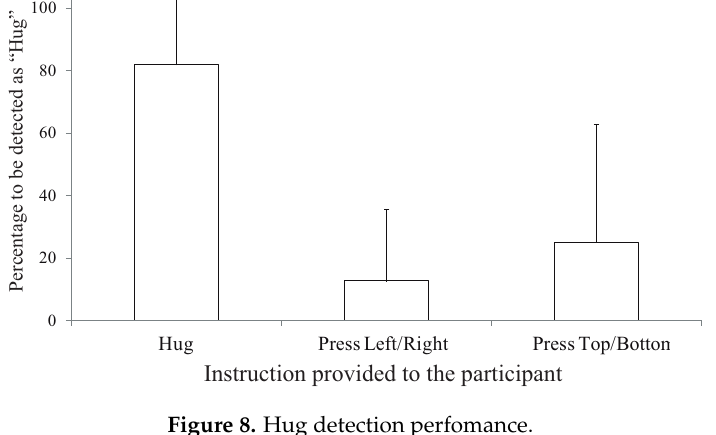
Figure 8. Hug detection perfomance.